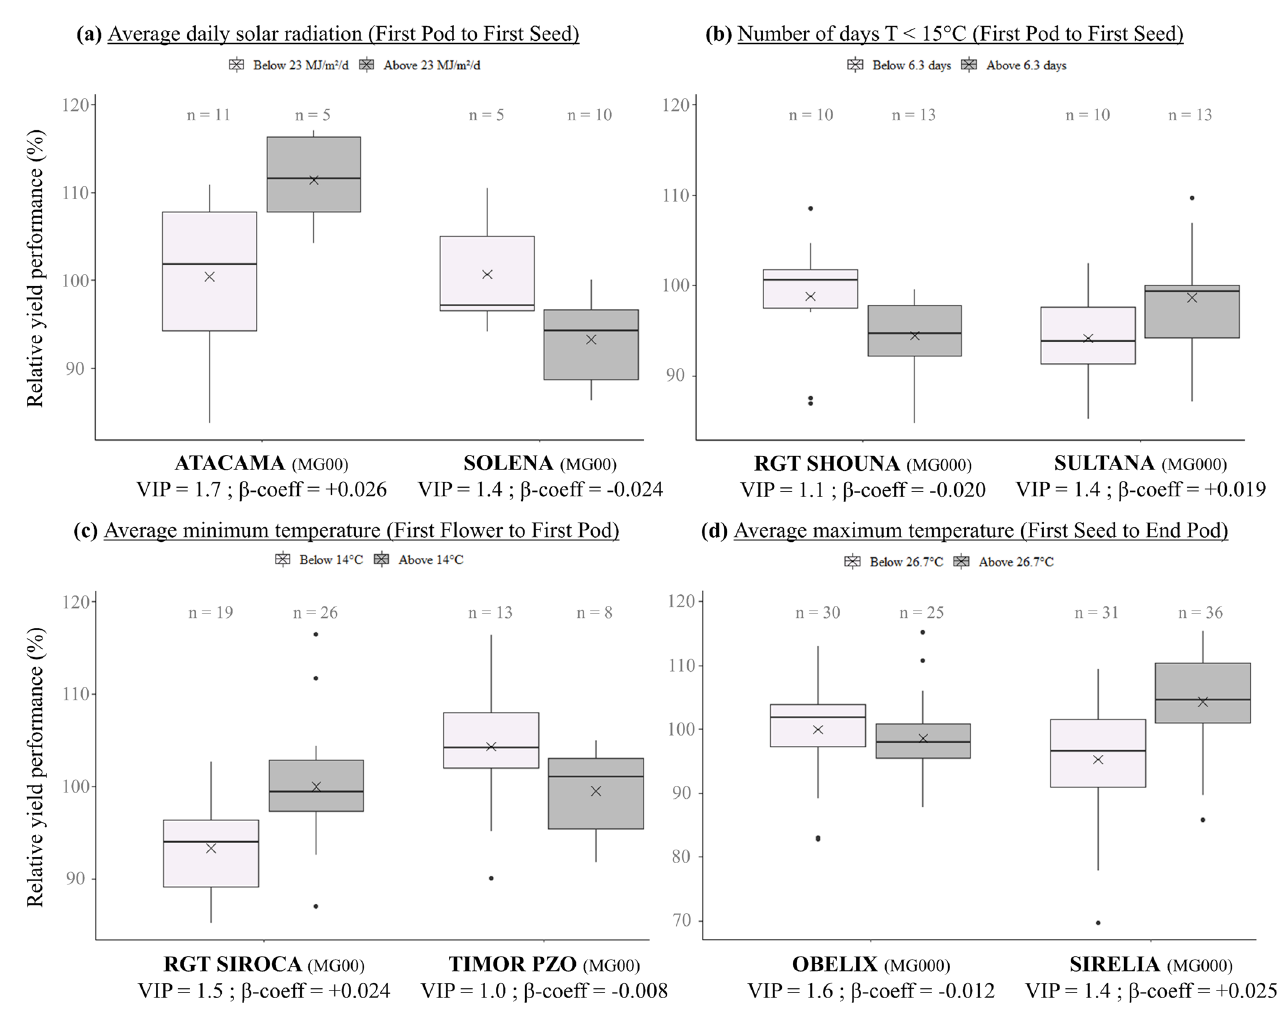
Figure 4. Relative yield performance of cultivars with contrasted response to different levels of selected eco-climatic factors frequently involved in GEI. ( a ) Relative yield of cv. ‘ATACAMA’ and cv. ‘SOLENA’ by average daily solar radiation during First Pod to First Seed (FPFS) phenophase. ( b ) Relative yield of cv. ‘RGT SHOUNA’ and cv. ‘SULTANA’ by number of days with a minimum temperature below 15 ◦ C during First Pod to First Seed (FPFS) phenophase. ( c ) Relative yield of cv. ‘RGT SIROCA’ and cv. ‘TIMOR PZO’ by average minimum temperature during First Flower to First Pod (FFFP) phenophase. ( d ) Relative yield of cv. ‘OBELIX’ and cv. ‘SIRELIA’ by average maximum temperature during First Seed to End Pod phenophase. Cultivar relative yields were calculated as the ratio of cultivar yield on the performance checks average yield present in all trial/year combinations. Only analyses showing a VIP greater than 1 for the selected eco-climatic factors were retained. Average VIP and β -coefficient are given for each cultivar. The numeric value “ n ” above each box corresponds to the number of environments included in each box plot. Each box displays the median, upper and lower quartiles of the respective distribution. Box whiskers represent the maximum and minimum range excluding any extreme outliers (shown as